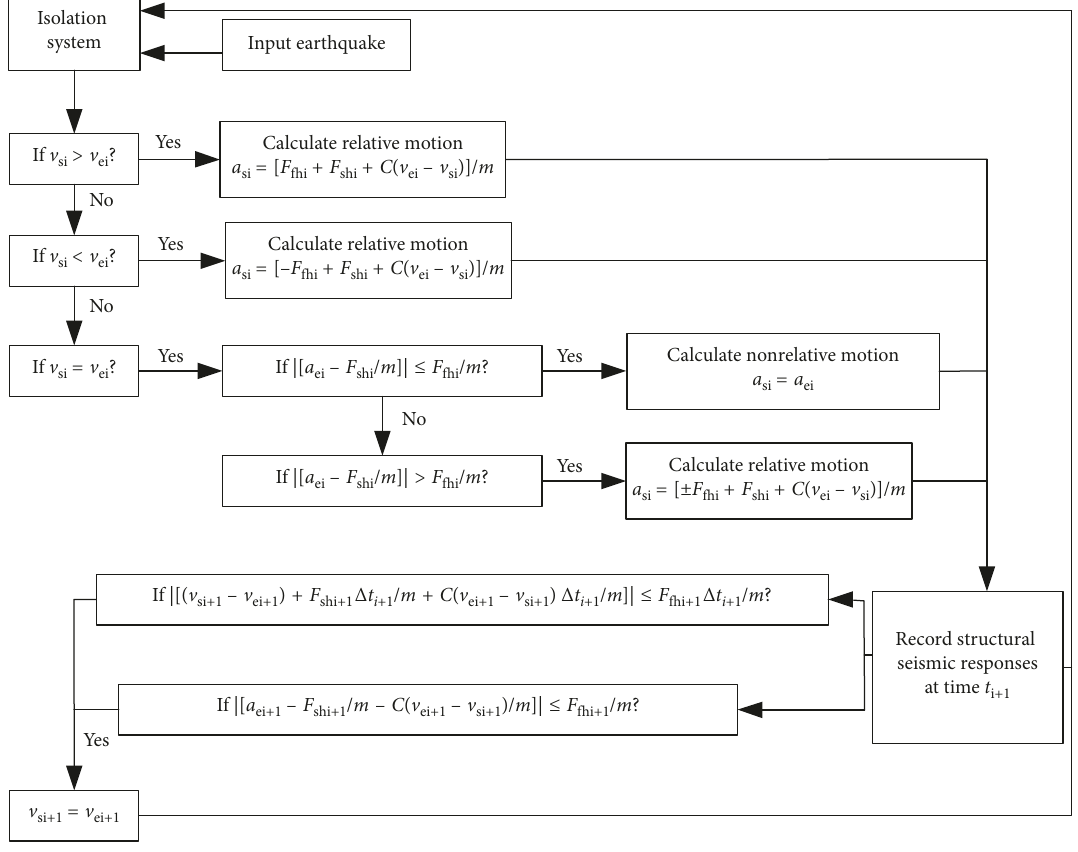
Figure 3: Flow chart of calculation method. Table 2: Damage states of structural